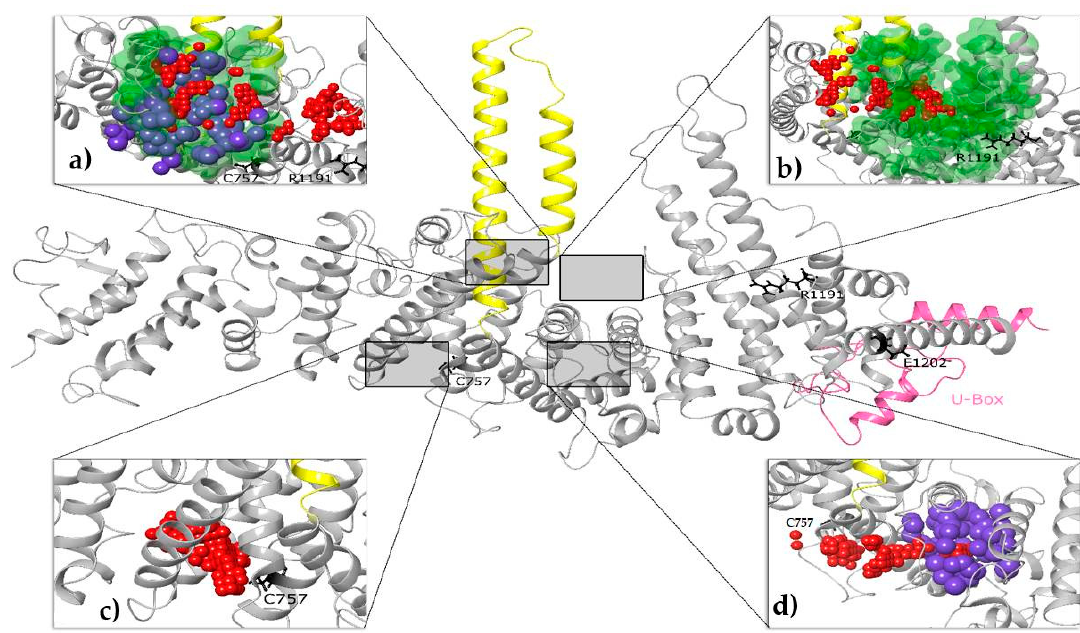
Figure 5. A three-dimensional structural homology model of human UBE4B, derived from comparative modelling with Ufd2p. The protein is shown in a “ribbon” representation, with a U-box domain colored pink. Important residues, found to be involved with Cdc48 binding [85,86], are depicted in a “ball and stick” representation, colored black. Selected a-helixes are colored yellow for viewing reference. Druggability analysis (likelihood of ligands binds tightly) [79–81] results are also illustrated in ( a – d ): Sitemap as small red spheres, fpocket as large blue spheres and CavityPlus as green surfaces. Only high-ranked cavities with particularly promising druggabilities were collected and compared from each program. All three algorithms converged with respect to the protein cavity shown in ( a ), whereas two out of the three suggested a promising druggability of cavities shown in ( b , d ). The highest druggability score (SiteScore: 1.293; D-score: 1.368; threshold for druggable sites: > 0.80) with Sitemap was observed for cavity shown in ( c ), which is adjacent to C757 residue.